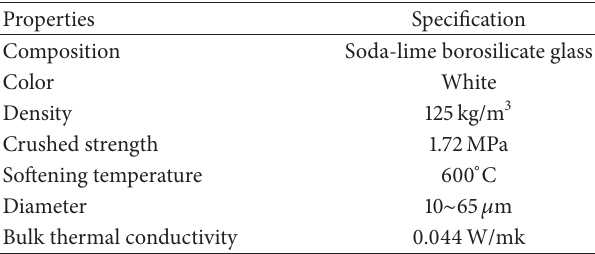
Table 2: Material properties of glass